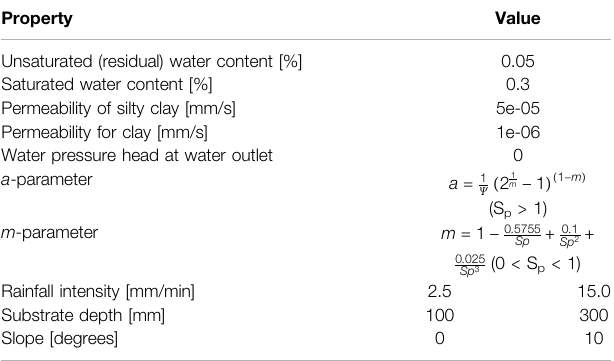
TABLE 1 | Material properties and parameters used in the SEEP/W model.